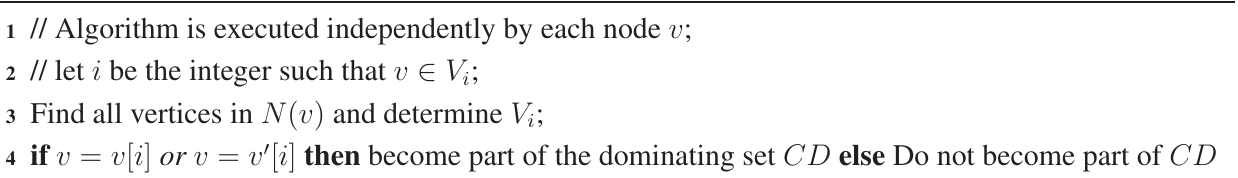
Algorithm 4 : Local algorithm for finding a connected dominating set in a unit line